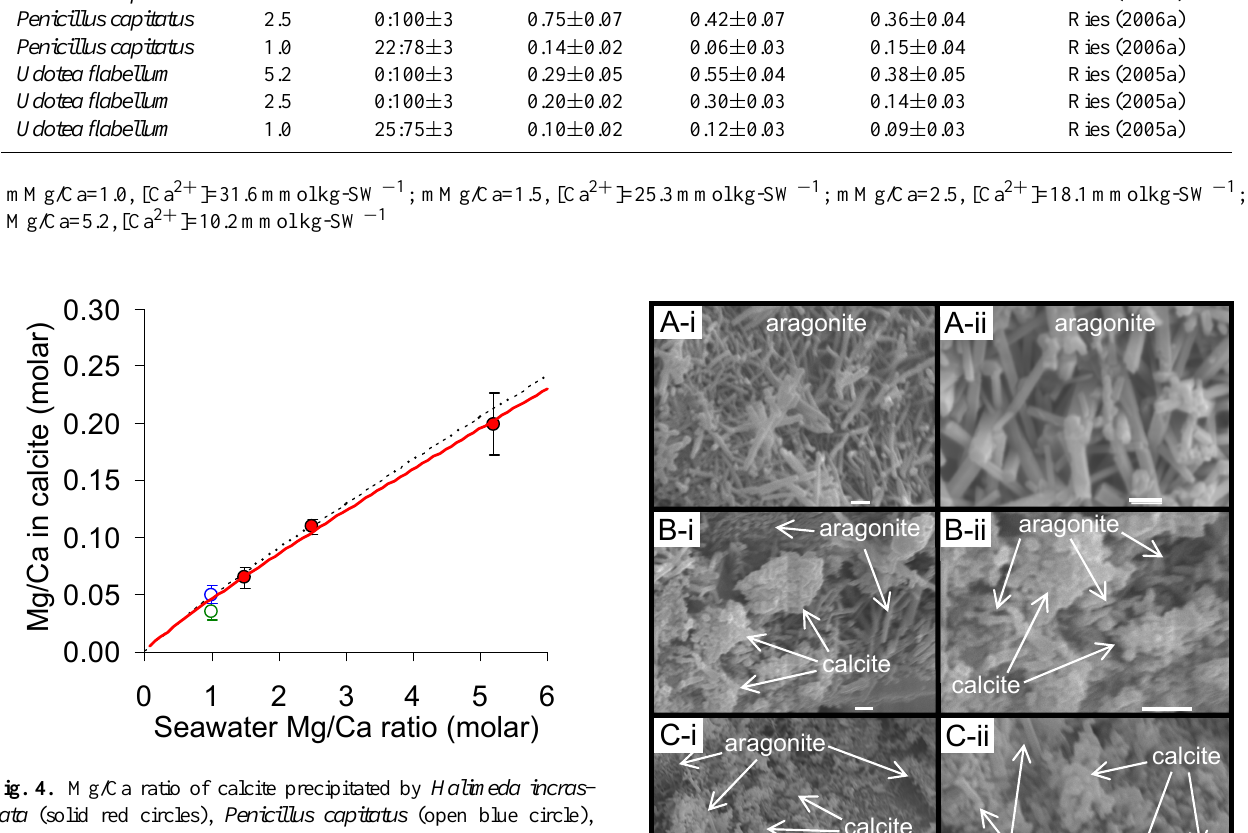
Fig. 4. Mg/Ca ratio of calcite precipitated by Halimeda incras- sata (solid red circles), Penicillus capitatus (open blue circle), and Udotea flabellum (open green circle) algae in the experimen- tal seawaters ( H. incrassata : Mg/Ca=1.5, [Ca 2 + ]=25.3mmolkg- SW − 1 ; Mg/Ca=2.5, [Ca 2 + ]=18.1mmolkg-SW − 1 ; Mg/Ca=5.2, [Ca 2 + ]=10.2mmolkg-SW − 1 ; P. capitatus and U. flabellum : Mg/Ca=1.0, [Ca 2 + ]=31.6mmolkg-SW − 1 ) , as determined by pow- der X-ray diffraction and energy dispersive spectrometry. Mg fractionation algorithm (solid red curve) is calculated for H. in- crassata using a least squares regression and is defined as Mg/Ca C =0.0460Mg/Ca sw 0 . 899 ( R 2 =0.996) at 25 ◦ C. Dashed black curve is Mg fractionation curve for calcite precipitated abiot- ically from seawater at 25 ◦ C (Mg/Ca C =0.0482Mg/Ca sw 0 . 898 , R 2 =0.930; F¨uchtbauer and Hardie, 1976). Error bars represent in- strument error and variation within and amongst specimens (data from Ries, 2005a, b, 2006a; Stanley et al., 2010).